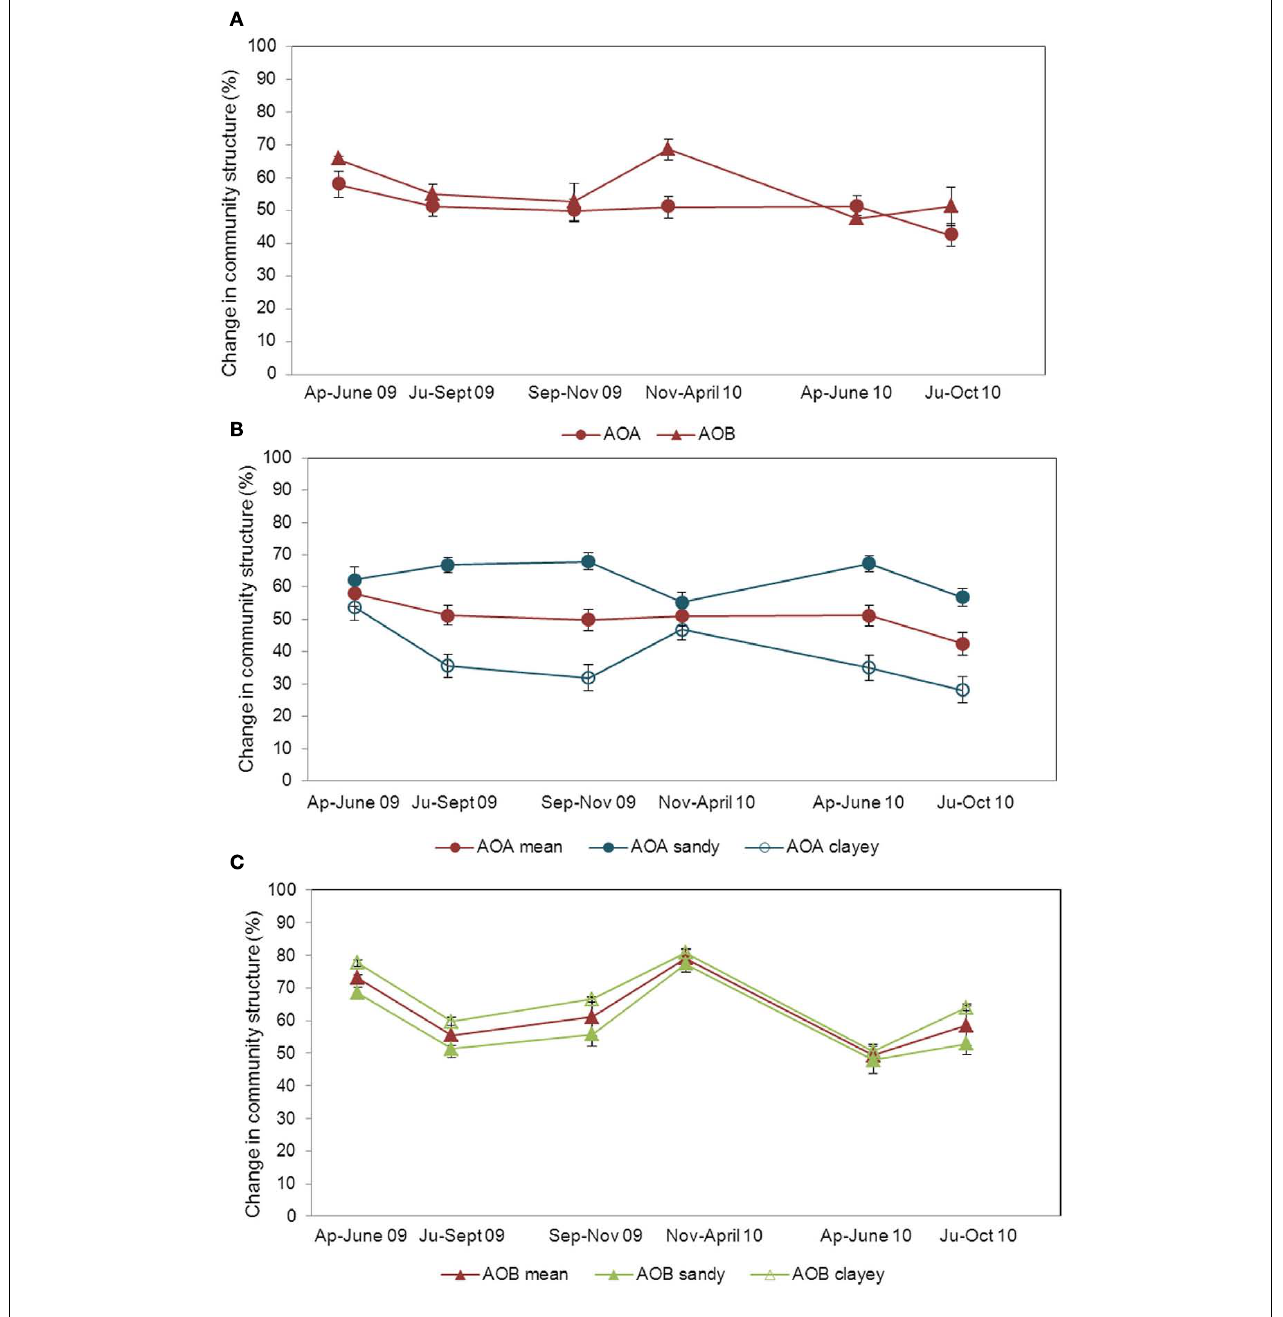
FIGURE 3 |Amplitude of variation in the community structure ofAOA andAOB. The fluctuations were determined by moving window analysis (MWA; Marzorati et al., 2008) based on DGGE profiles as a mean of all soils [ (A) ; Δ t AOA = 53.65 ± 3.37%; Δ t AOB = 62.76 ± 2.10%], and separated in sandy